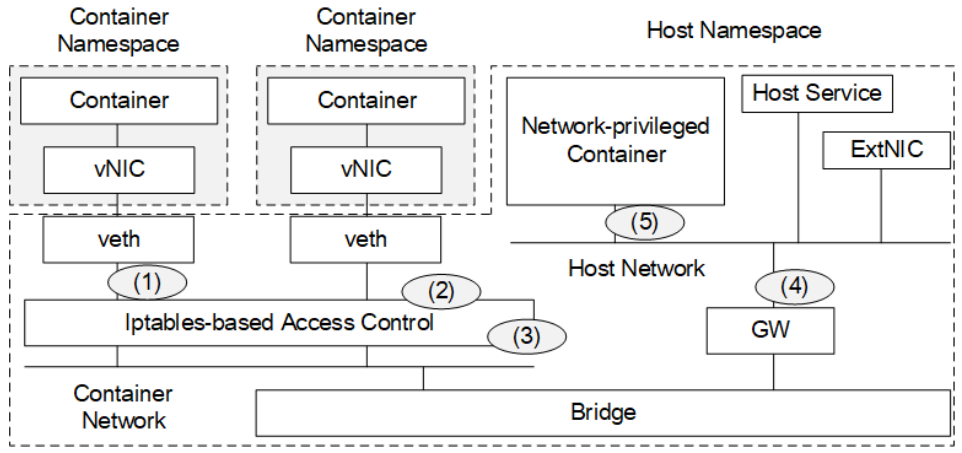
Figure 12. Container network security challenges